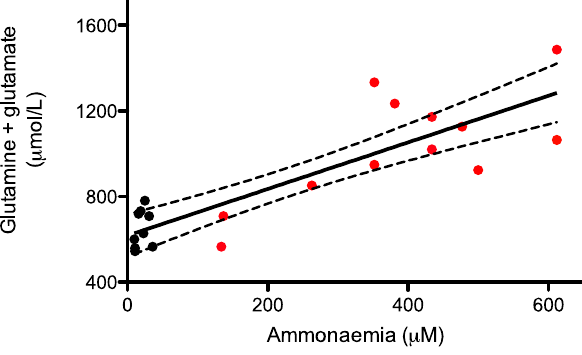
Figure 3. Correlation between ammonaemia versus glutamine and glutamate levels in dried blood spots. Parameters were measured in wild type (black; n = 9) and untreated Asl Neo/Neo (red; n = 15) littermates. Spearman’s rank correlation coefficient test (r s = 0.74; p < 0.0001).